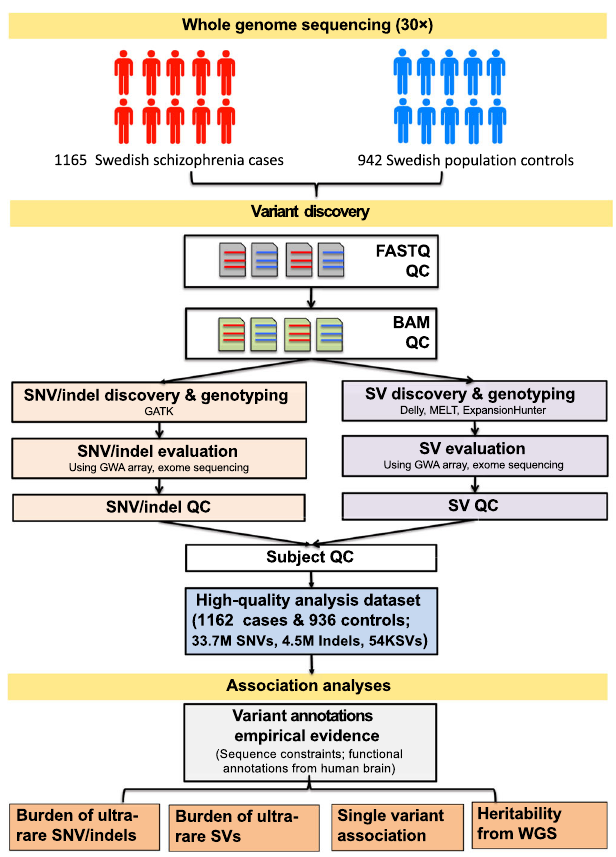
Fig. 1 Overview of WGS analysis. WGS data were generated using identical protocols at the same facility and all WGS data were jointly processed and analyzed. The schizophrenia cases also had GWA SNP array and exome- sequencing data for comparison for the purpose of quality assessment. We started with 1165 schizophrenia cases and 942 ancestry-matched population controls. After QC, 1162 cases and 936 controls remained.